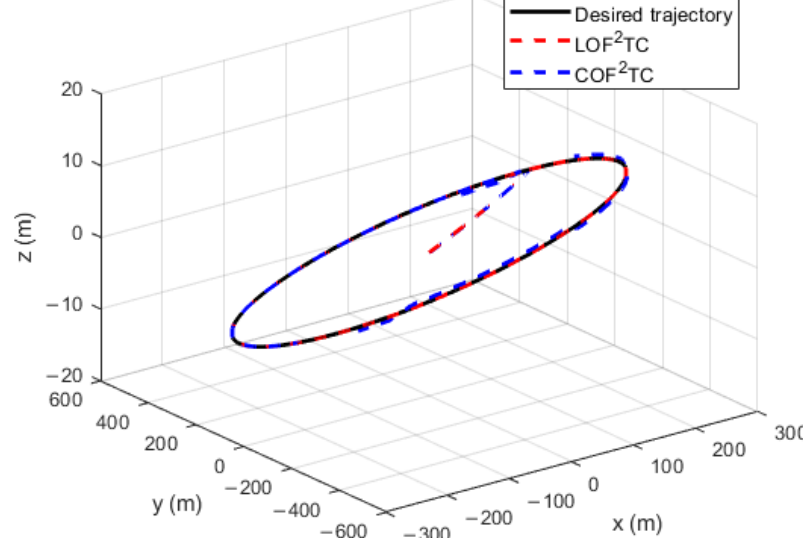
Figure 9. Three-dimensional tracking trajectory for spacecraft formation configuration maintenance.